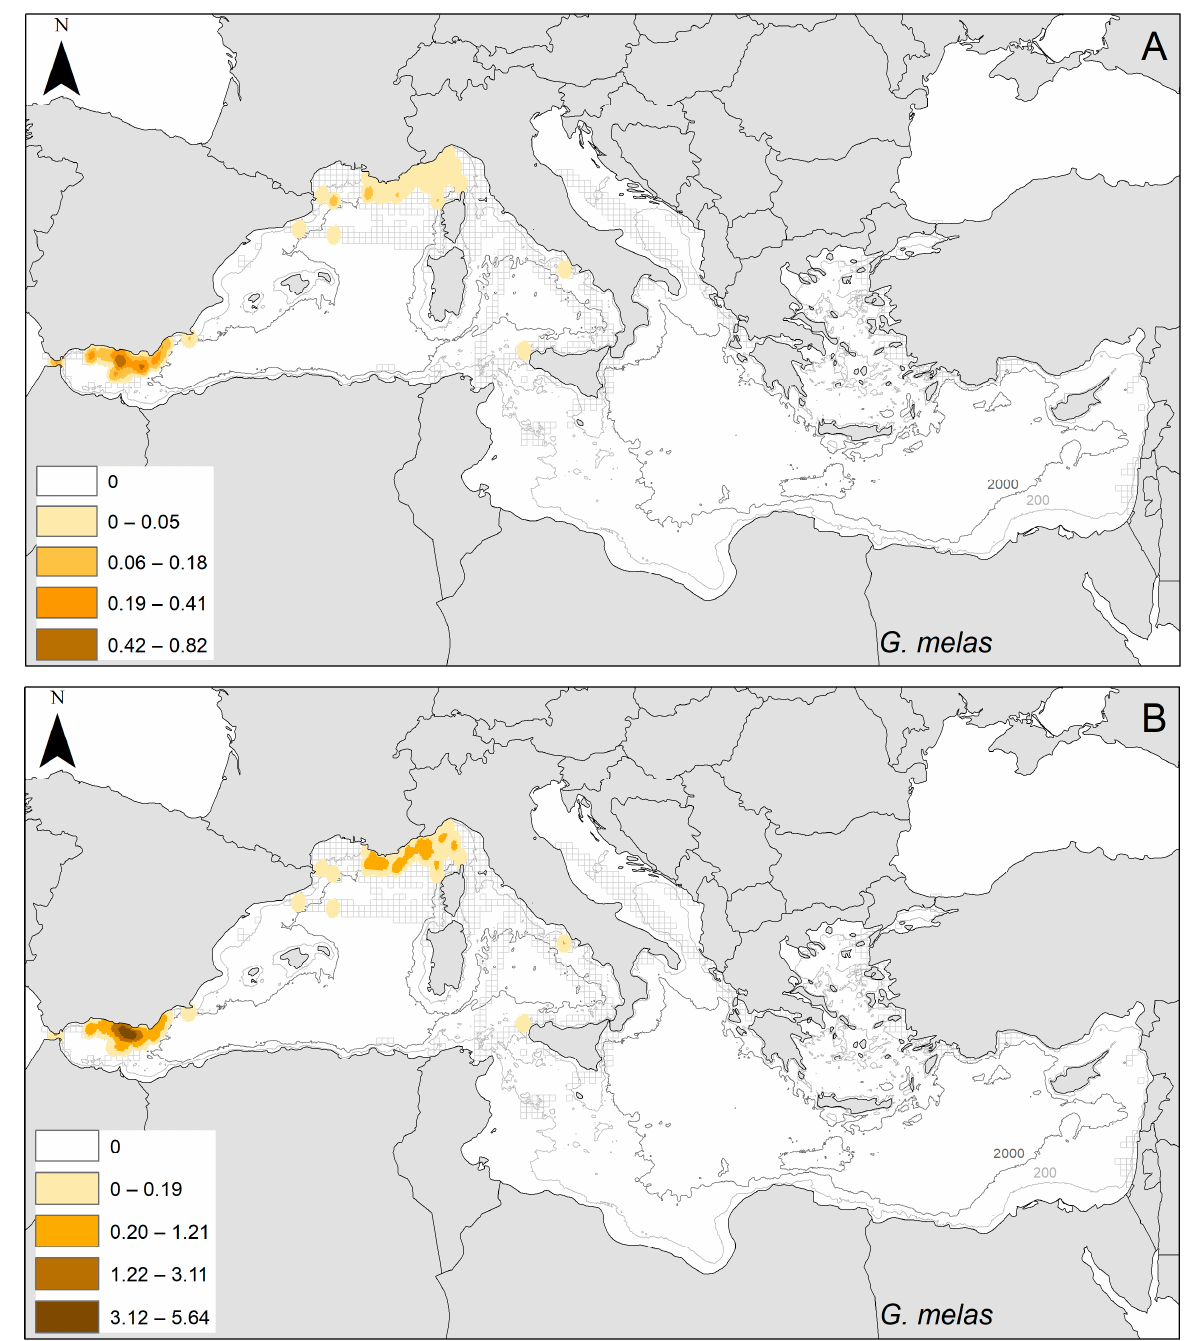
sampling areas of the west basin, with a scattered distribution. The ER is maximum in the Alboran Sea and lower inside the Mediterranean. The Risso’s dolphin shows a clear preference for the waters outside the continental shelf (>200 m) and a slight preference for the waters of the continental slope (200–2000 m). The prevalence map ( B ) shows the same scattered pattern and, in the Alboran Sea, the prevalence is relatively low (despite the high ER), probably because of the coexistence of other species (Kernel density parameters: cell size x, y = 5 × 5 km; radius ≈ 30 km; criterion for division into classes: natural breaks).